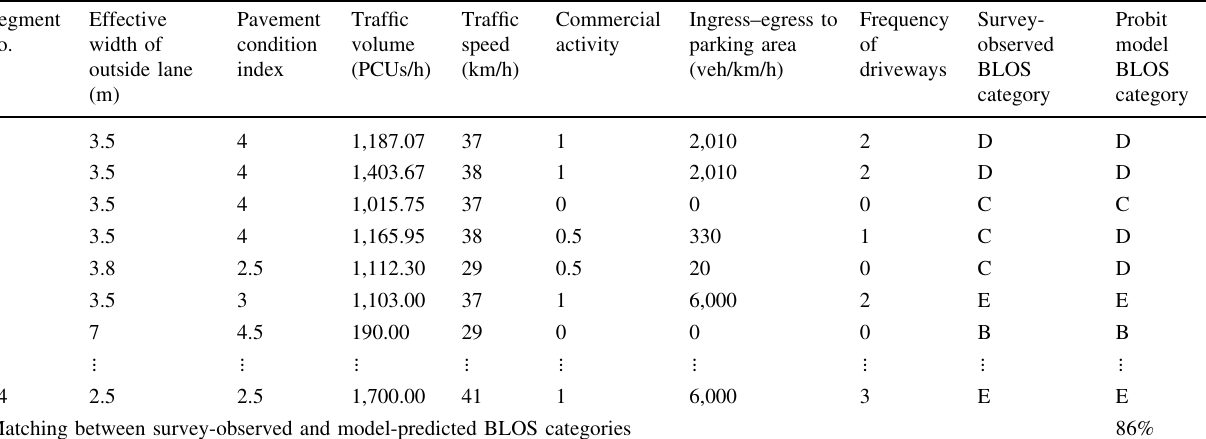
Table 8 Matching between observed and predicted BLOS categories (A–F) Segment